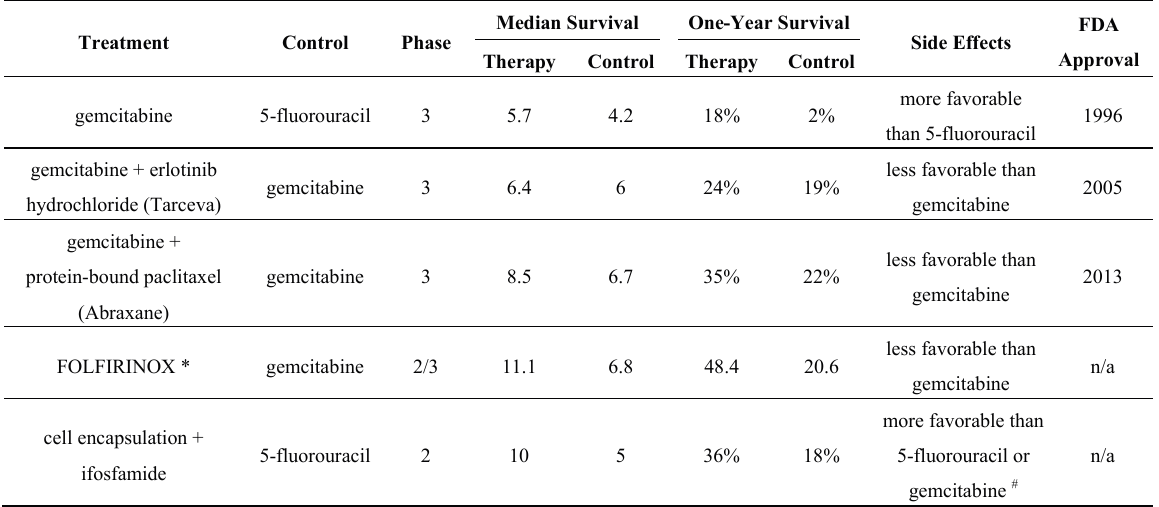
Table 6. Summary of recent trial data for pancreatic cancer